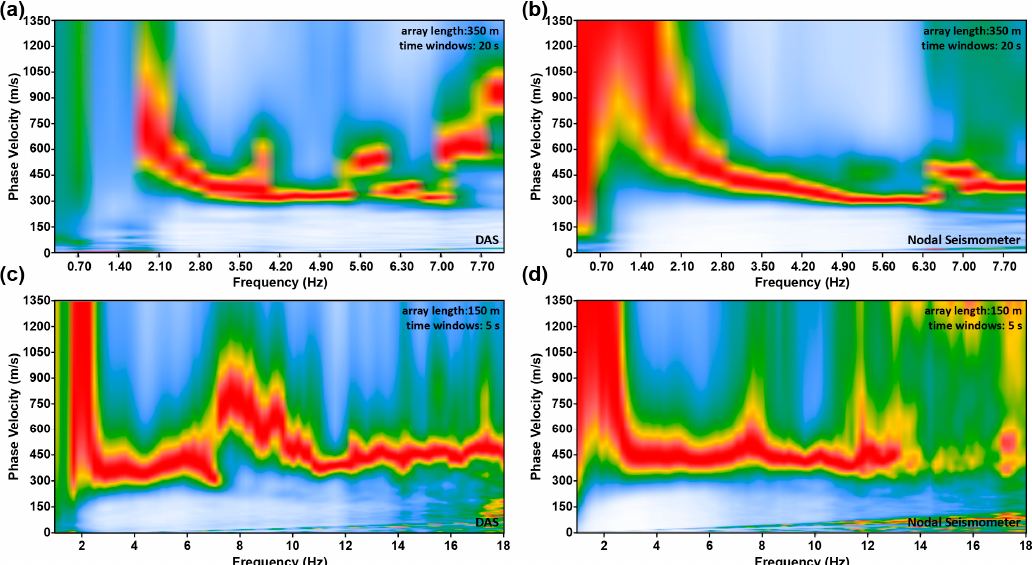
Figure 6. Examples of the frequency–phase velocity spectra based on DAS ( a , c ) and nodal seismometer ( b , d ) data. The virtual source point is located near 352 m, the length of receiving array and each time segment are 350 m, 20 s ( a , b ), and 150 m, 5 s ( c , d ).